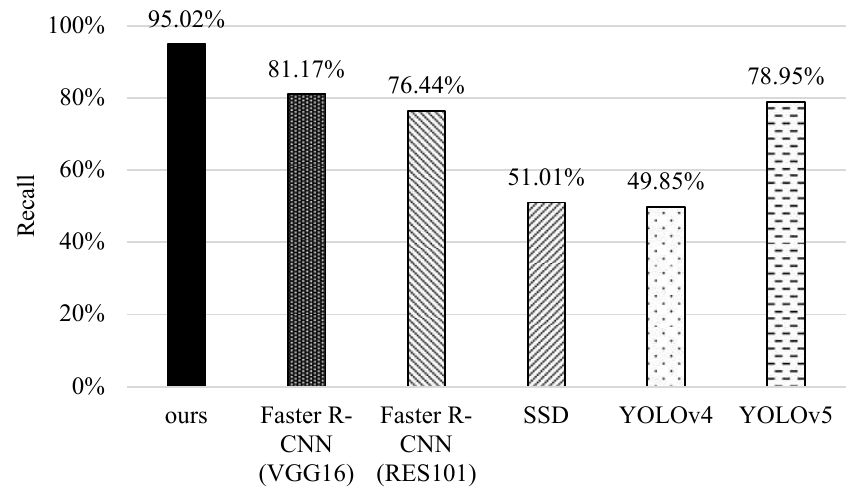
Figure 13. Comparisons of the precision of different methods.